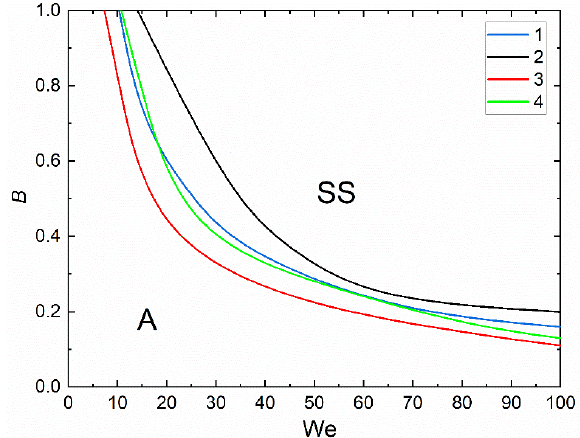
Figure 12. Interaction regime maps for used motor oil droplets colliding with carbonaceous particles of coals of different ranks at ∆ = 1, R d = R p = 1.1–1.2 mm: 1—dry particle of coking coal filter cake; 2—wetted particle of coking coal filter cake; 3—dry particle of anthracite; 4—wetted particle of anthracite. A — agglomeration; SS — stretching separation.